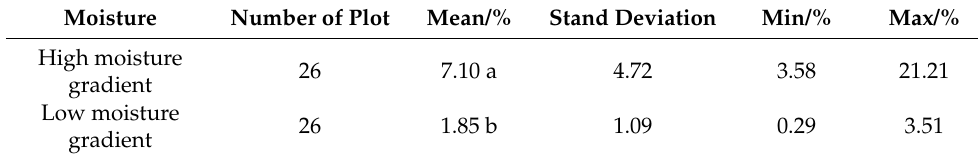
Table 2. Basic statistical value of soil water content in different moisture